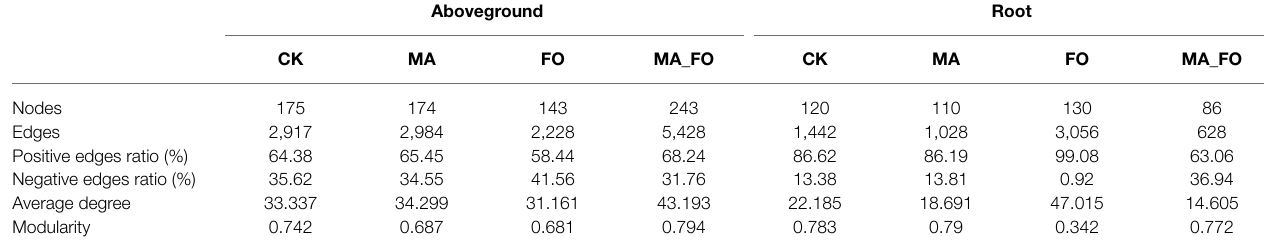
TABLE 4 | Key topological features of fungal networks in aboveground and root of ginseng under different inoculation treatments. Aboveground